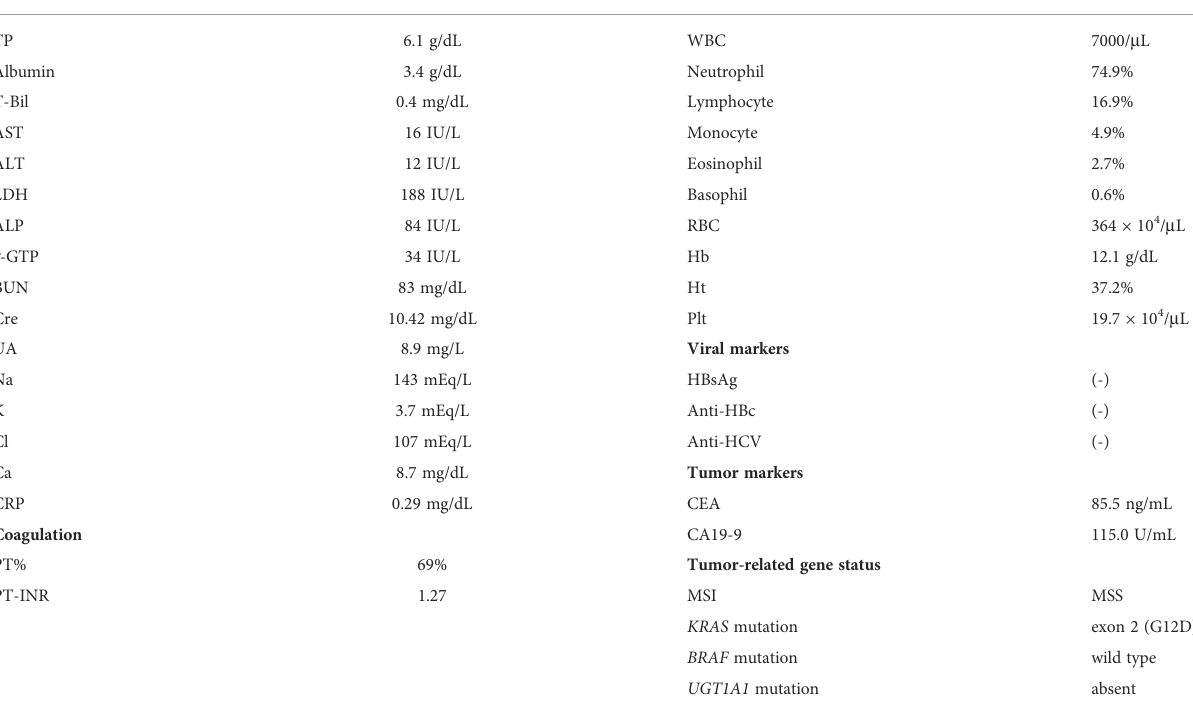
TABLE 1 Laboratory data on